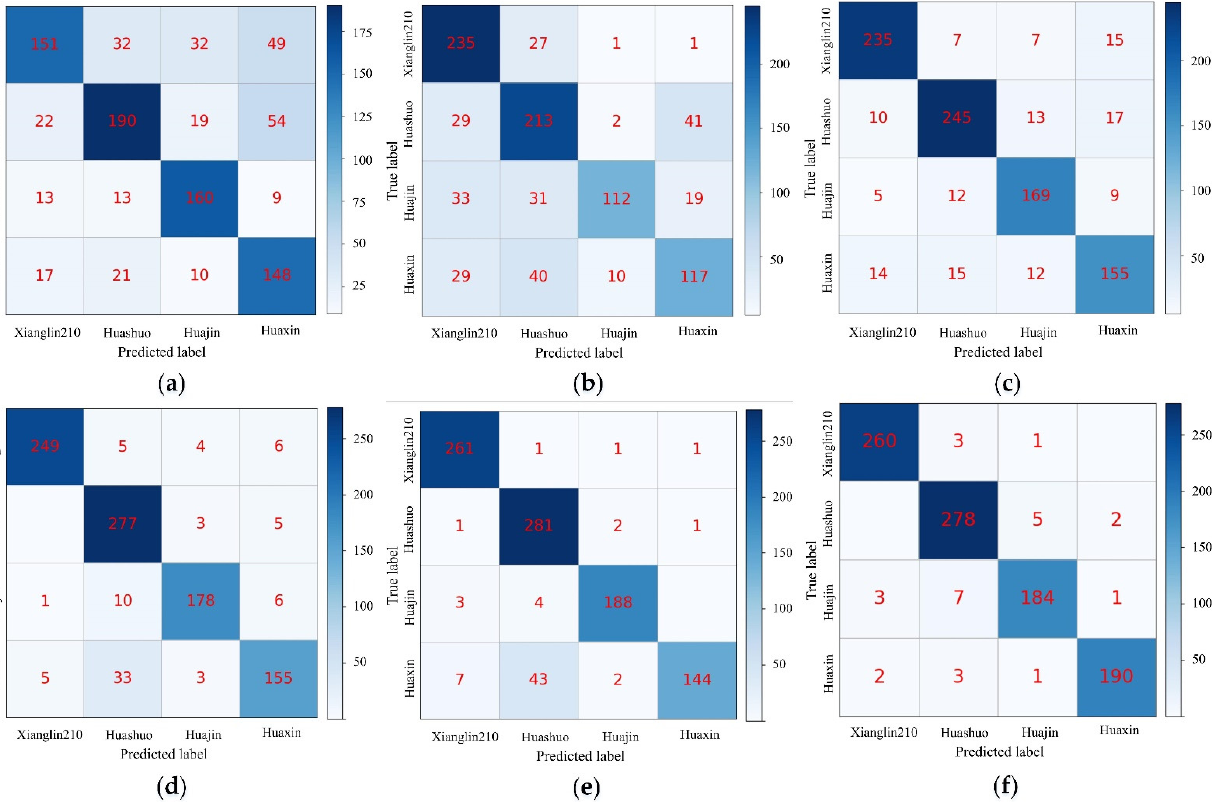
Figure 6. Confusion matrix of six oil tea cultivar identification models. ( a ) InceptionV3; ( b ) VGG16; ( c ) ResNet50; ( d ) EfficientNet-B4; ( e ) EfficientNet-B4-SE; ( f ) EfficientNet-B4-CBAM.